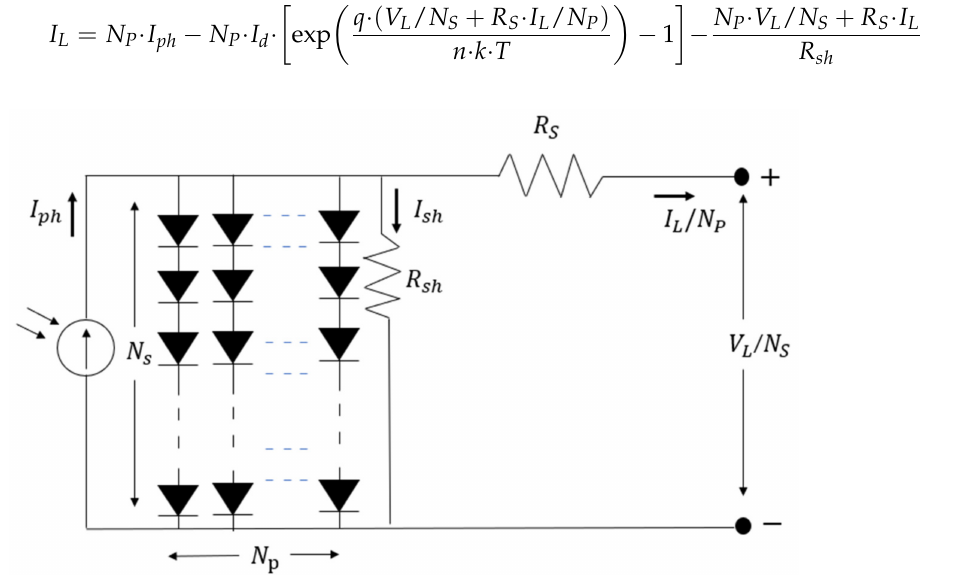
Figure 3. The equivalent circuit of a PV